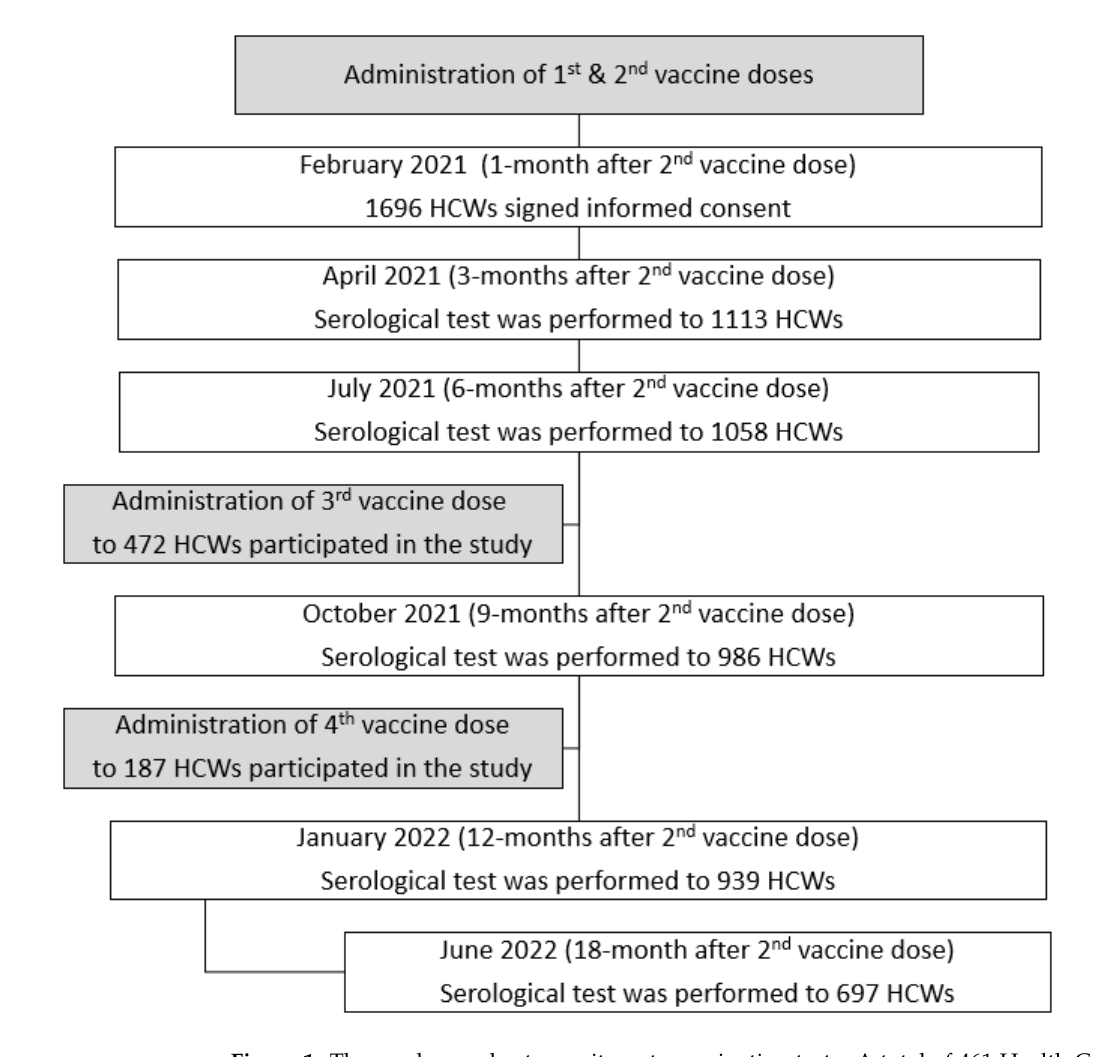
Figure 1. The serology cohort recruitment examination tests. A total of 461 Health Care Workers attended all 6 serology tests.